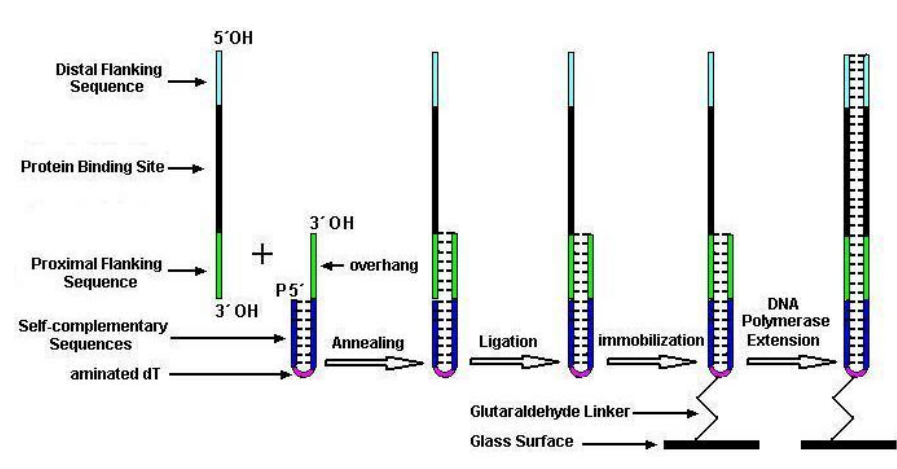
Figure 1. Scheme of the unimolecular dsDNA microarray fabrication Verification of CO/TO Annealing and Ligation